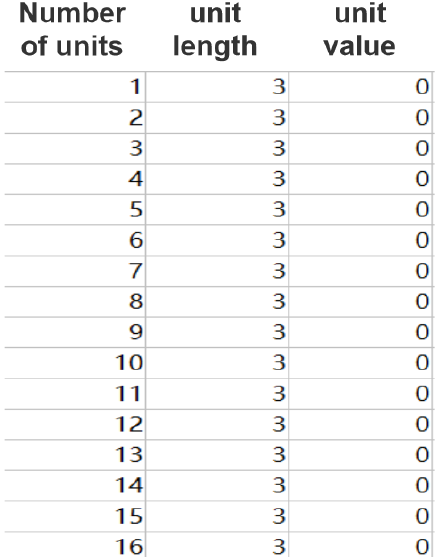
Figure 12. An example of Map units . Table 4. The capacity and utilization of DC using